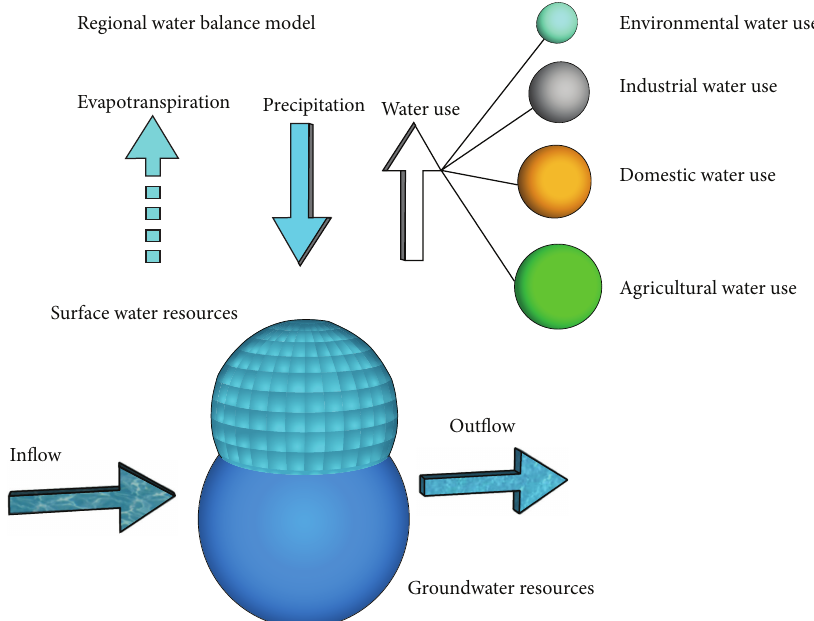
Figure 2: Theoretical water balance model of Beijing Water